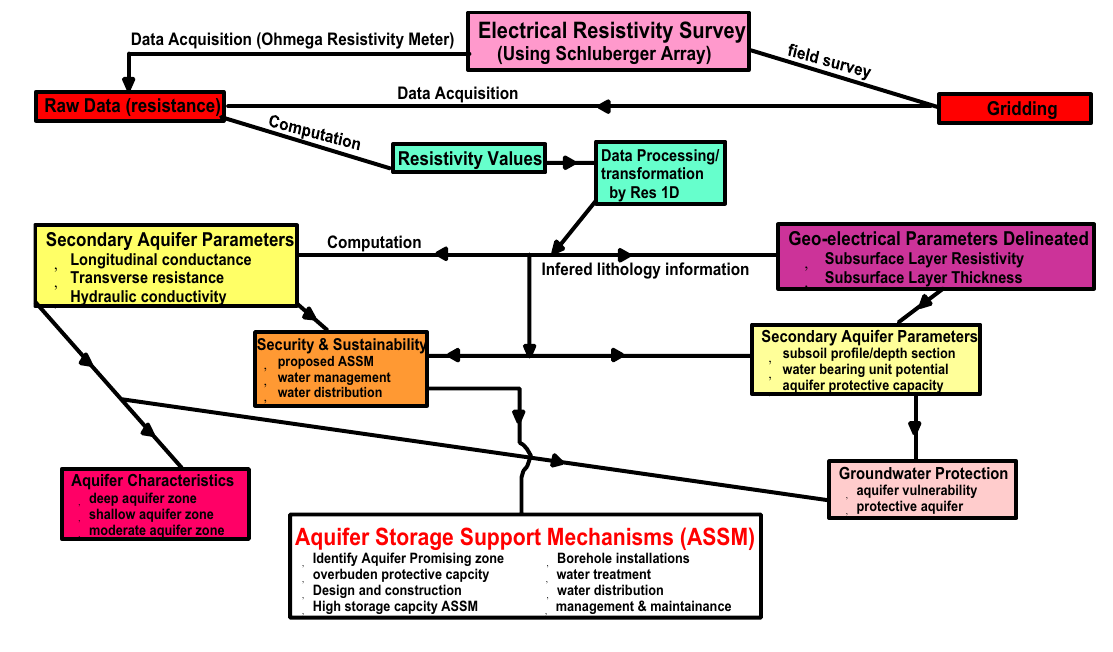
Fig. 2 Flowchart illustrating the processes and results